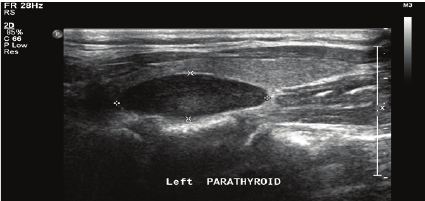
Figure 1: A well-defined, oval shaped, hyperechoic lesion identified in the inferior aspect of the left thyroid lobe exhibits mild-to- moderate internal vascularity on Doppler interrogation. It measures about 2.3 × 1 × 0.8 cm suggestive of parathyroid